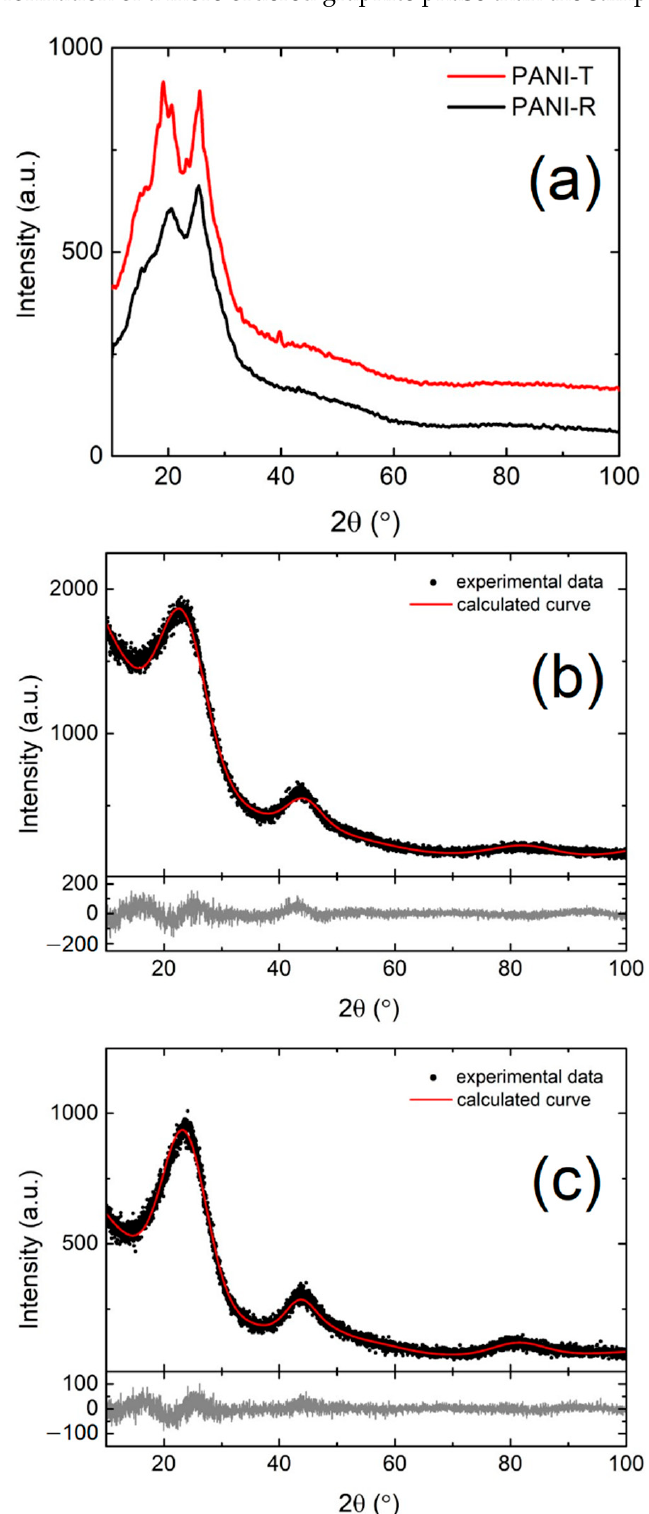
Figure 3. ( a ) XRD patterns of PANI-R and PANI-T; XRD experimental data and Rietveld refinement with residuals at the graphs bottom of ( b ) PANI-R-900 and ( c ) PANI-T-900 .